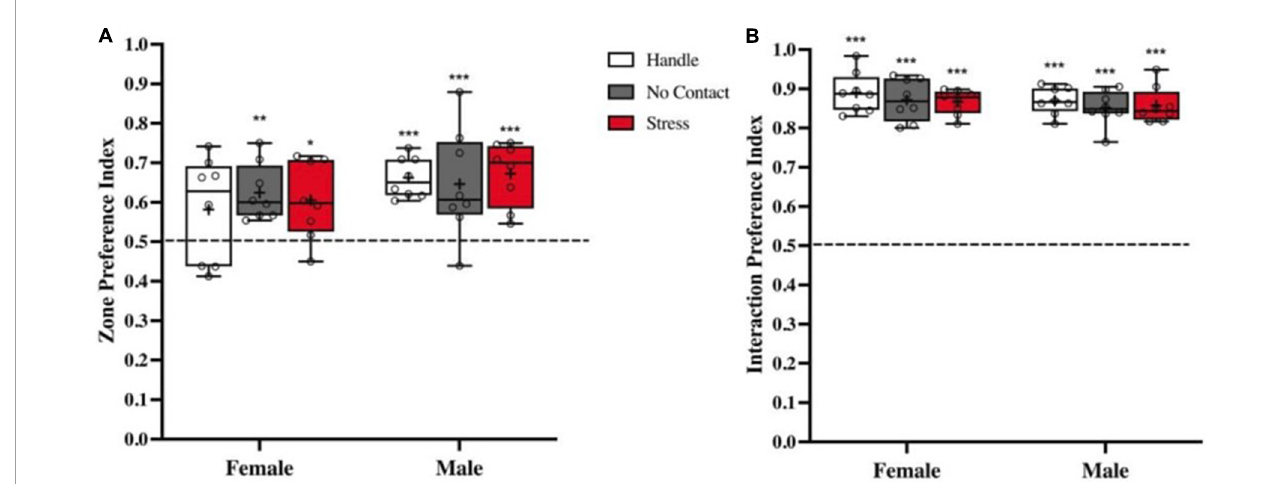
FIGURE3 Sociability is not impacted by preadolescent exposure to unfamiliar male. Preference indexes (M ± Minimum and Maximum) comparing time spent with the conspecific vs. empty cage during acquisition. (A) Zone preference indexes showed that all groups in both sexes spent more time in the zone associated with the conspecific except the Female Handled group (* p < 0.05, ** p < 0.01, *** p < 0.001 when compared to chance: dashed line at 0.5). (B) Interaction social preference indexes revealed that all conditions in both sexes spent more time interacting with the conspecific than the empty wire cage (*** p < 0.001 compared to chance).